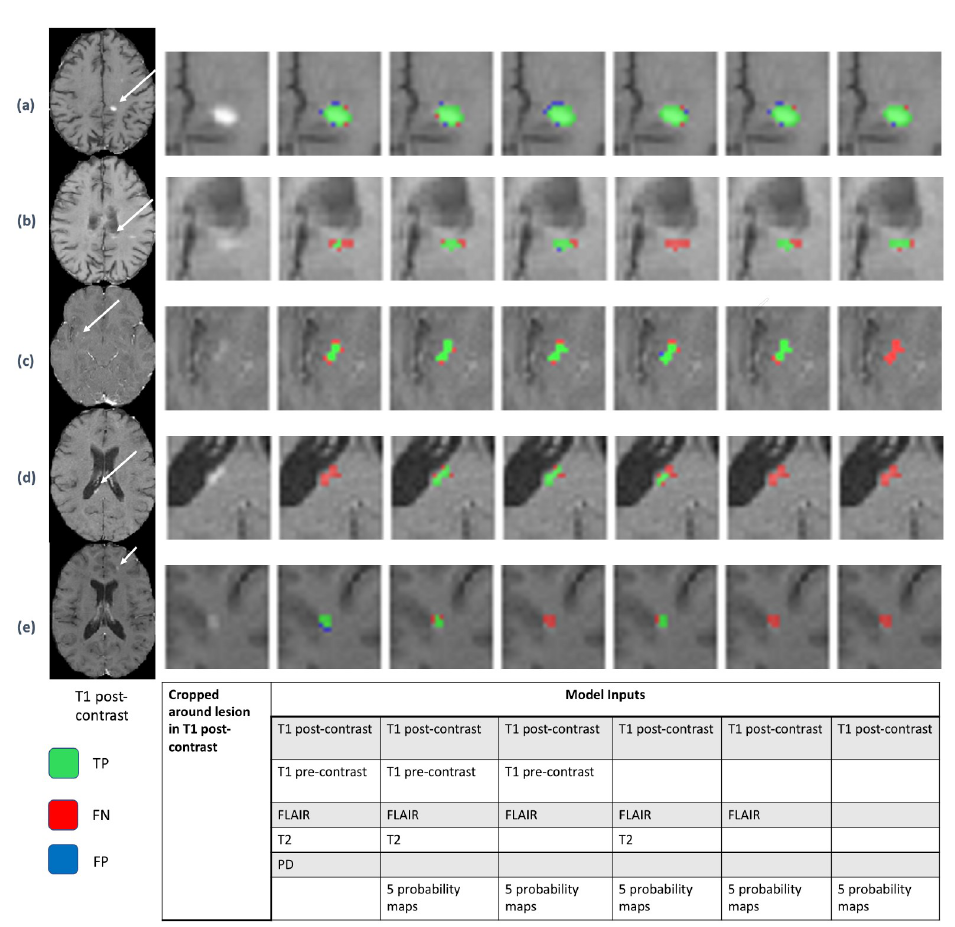
Fig 3. Predicted images for different input sequences. Each row represents image slices from different MRI sequences. The first column represents T1 post-contrast images and the second column represents the enlarged T1 post-contrast images around the lesion of interest. The other columns are performances of UNet and random forest model for different input sequences, which are tabulated below. The red regions are false negative segmentation, green is an overlap, and blue regions are false positives. The white arrow shows the lesion of interest. The first row (a) shows an example of lesion detection using any input while the second row (b) shows change in lesion segmentation volume due to different input. The third row (c) shows a lesion that cannot be detected using only T1 post-contrast. The fourth row (d) shows an example of lesion detection where T1 pre-contrast, T1 post-contrast and FLAIR are most influential to detect. The fifth row (e) shows a lesion that cannot be detected without T2.